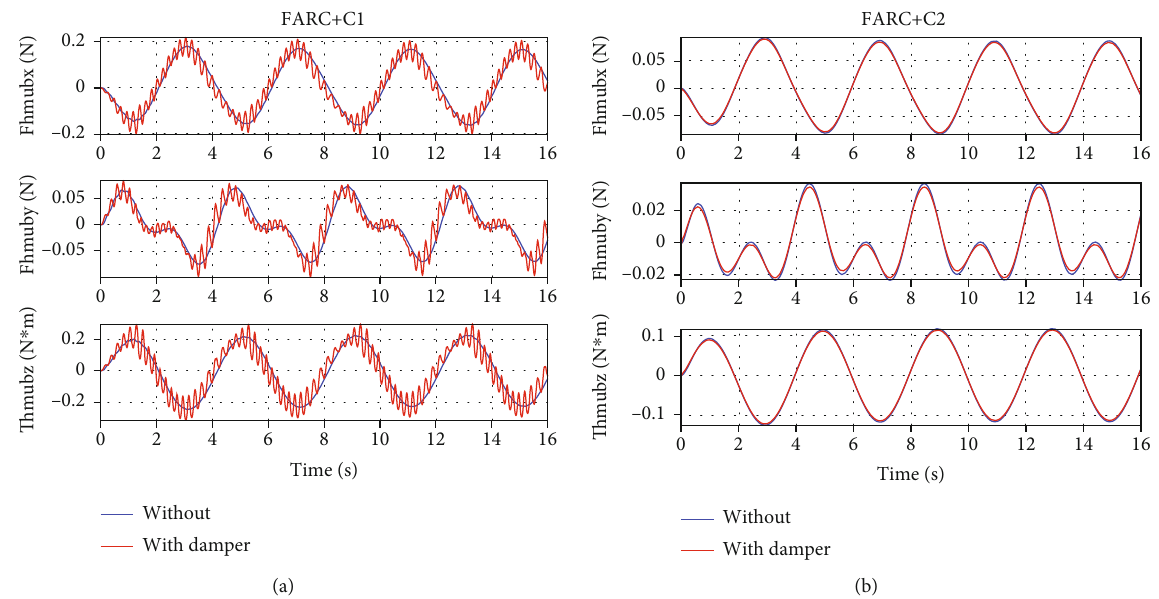
Figure 12: Human-machine interaction force of double leg support for Set4: (a) at the back for FARC+C1 and (b) at the back for